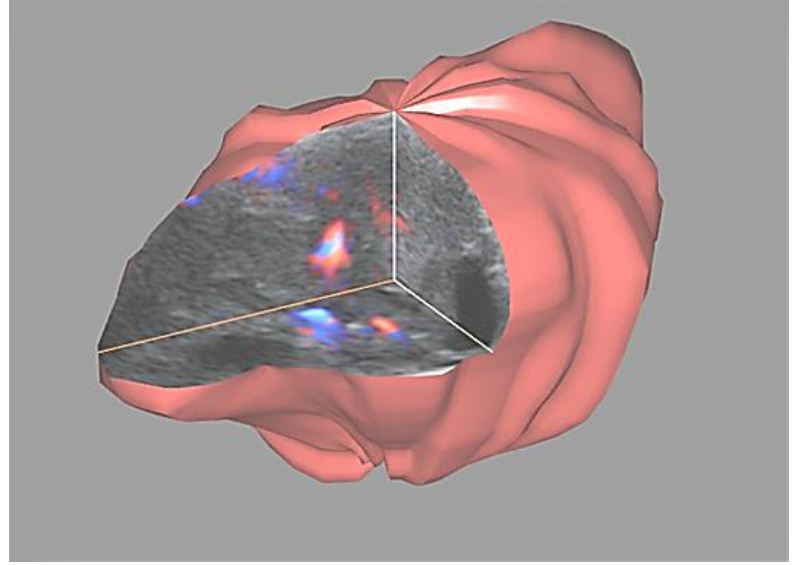
Figure 11. Virtual shell corresponding to the ovarian tumor in a 3D visualization with visible vessels inside the tumor (High Definition Flow). Vascularization Index value calculated on this basis was equal to 13.